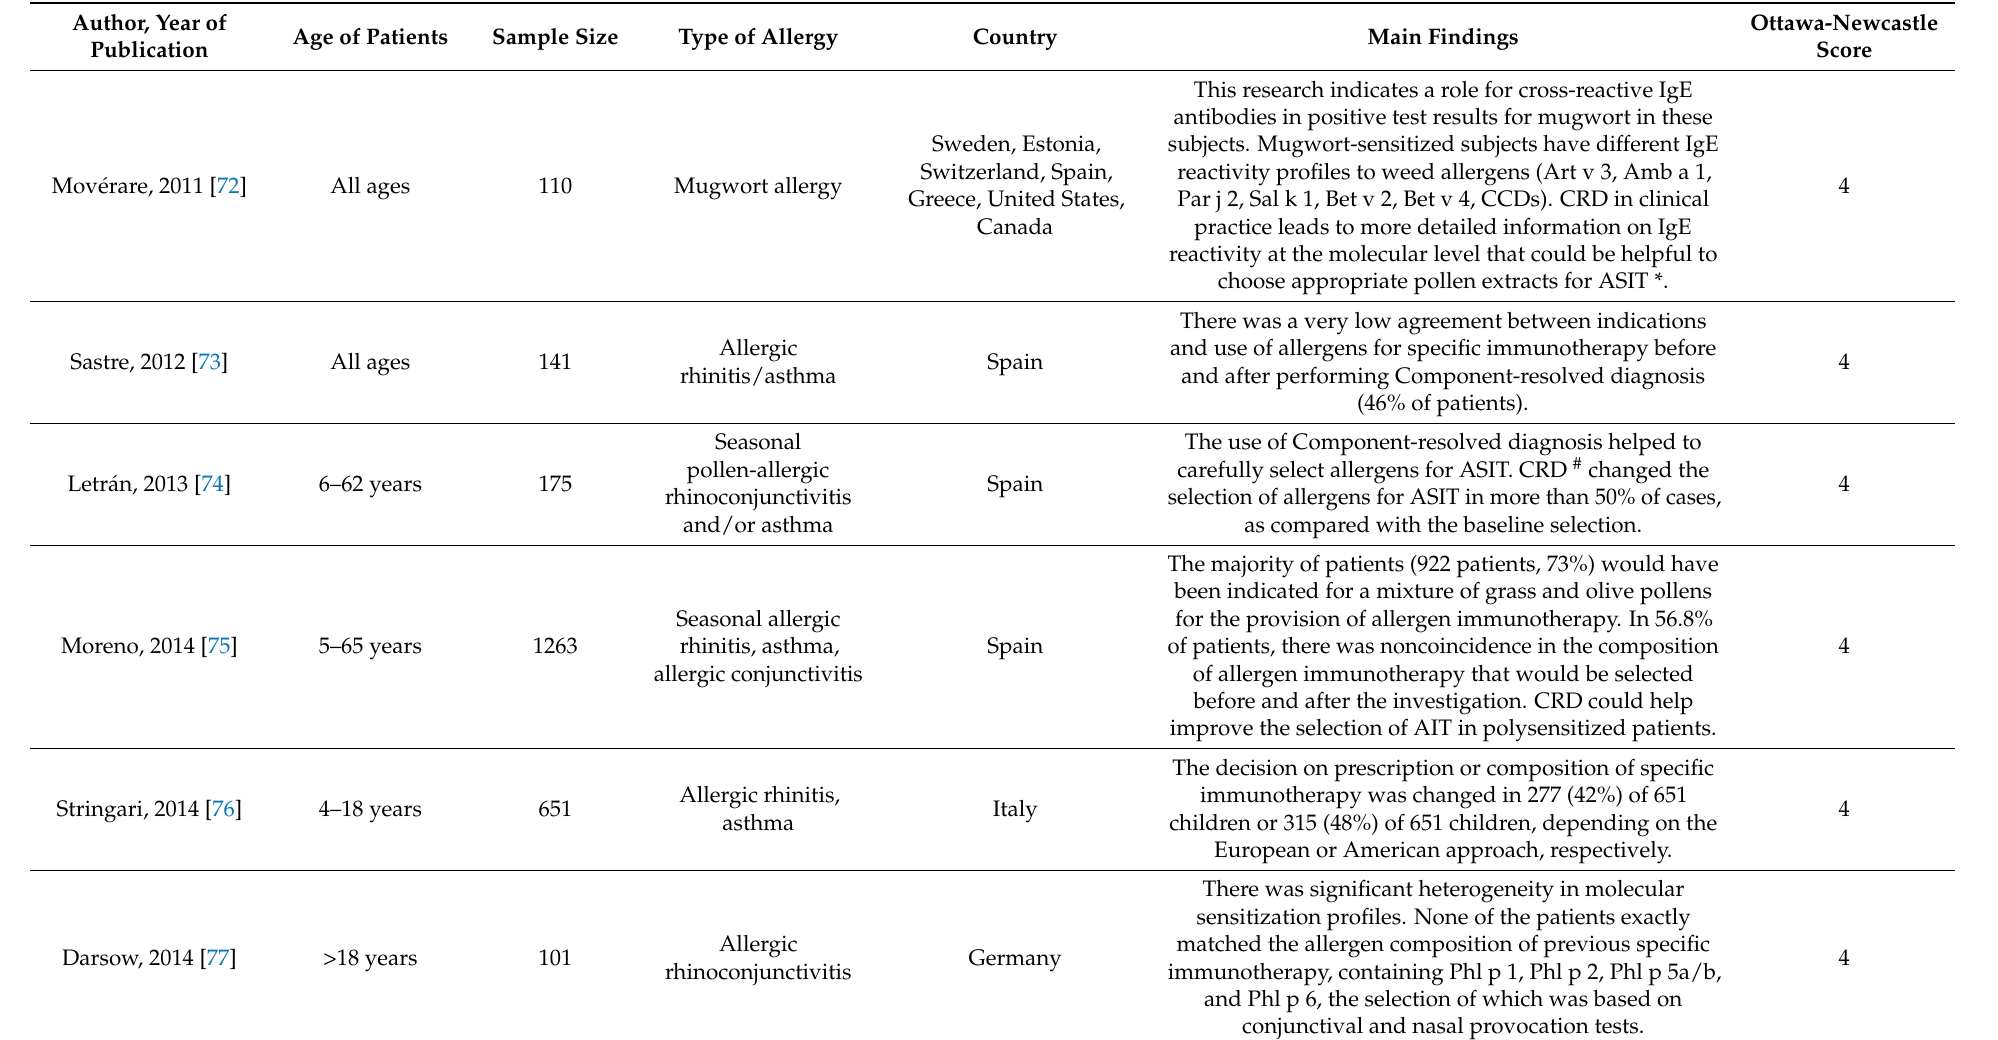
Table 1. Studies evaluating the role of component-resolved diagnosis in providing allergen-specific immunotherapy to patients with seasonal allergic